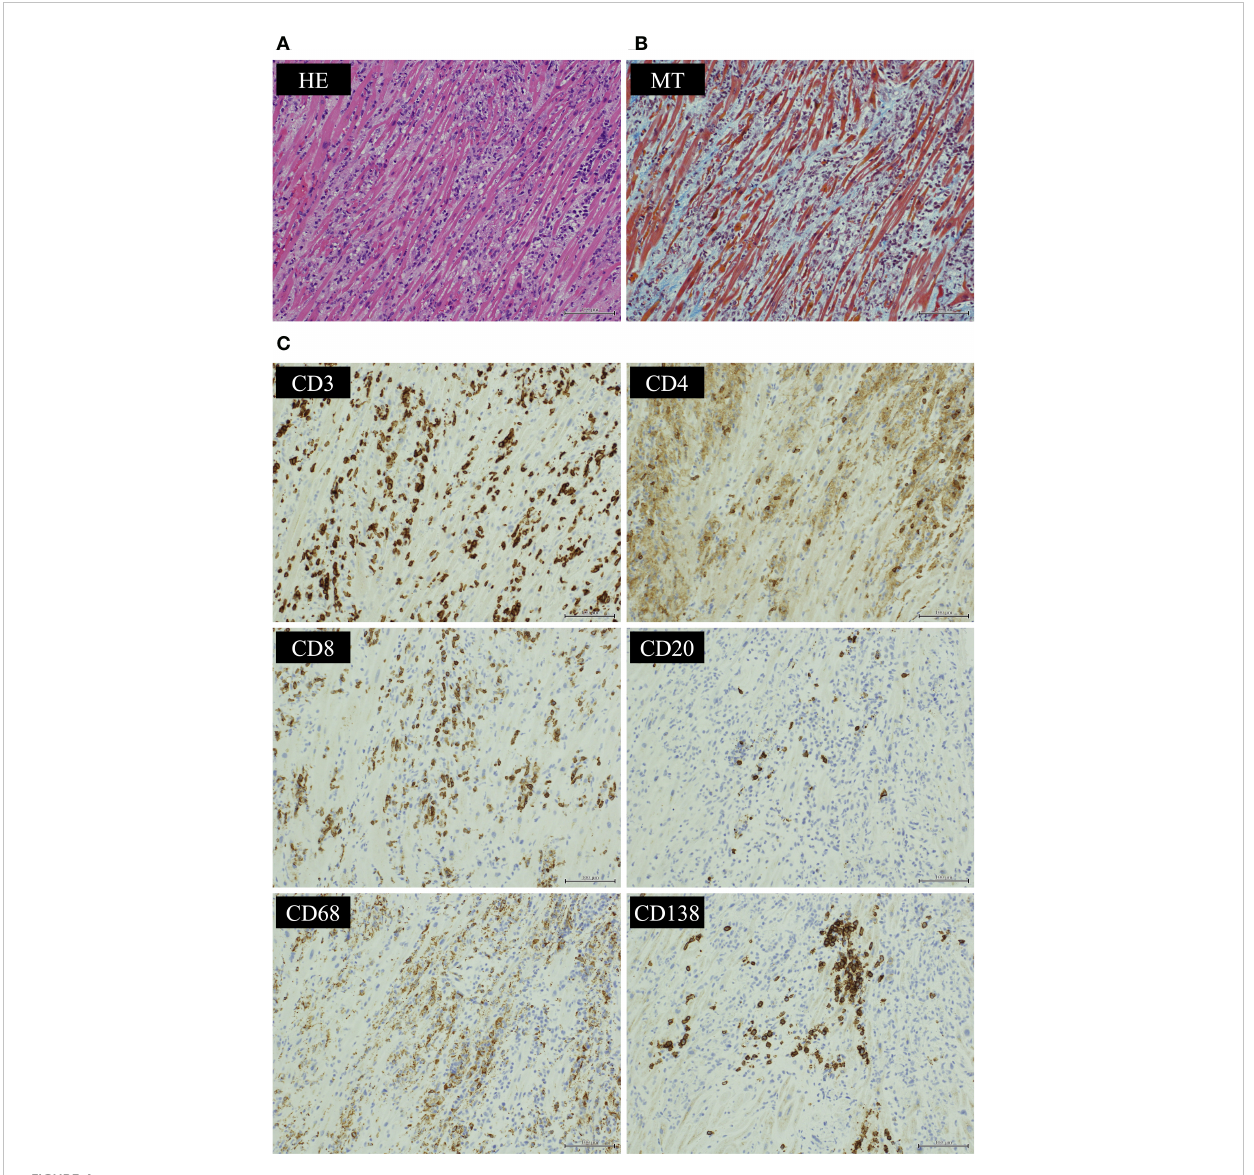
FIGURE 4 Histological fi ndings of endocardial biopsy. Histological fi ndings of the myocardium showed (A) an in fi ltrate of in fl ammatory cells predominantly composed of lymphocytes by hematoxylin-eosin (HE) staining and (B) granulation fi brosis of the stroma by Masson ’ s trichrome (MT) staining. Immunostaining of the tissue showed (C) CD3-positive T cells in fi ltrated more than CD20-positive B cells. CD8-positive T lymphocytes in fi ltrated more than CD4-positive T lymphocytes. In fi ltration of CD68-positive macrophages and CD138-positive plasma cells was also observed. (HE ×200, MT ×200 and CD3/CD4/CD8/CD20/CD68/CD138 immunostaining